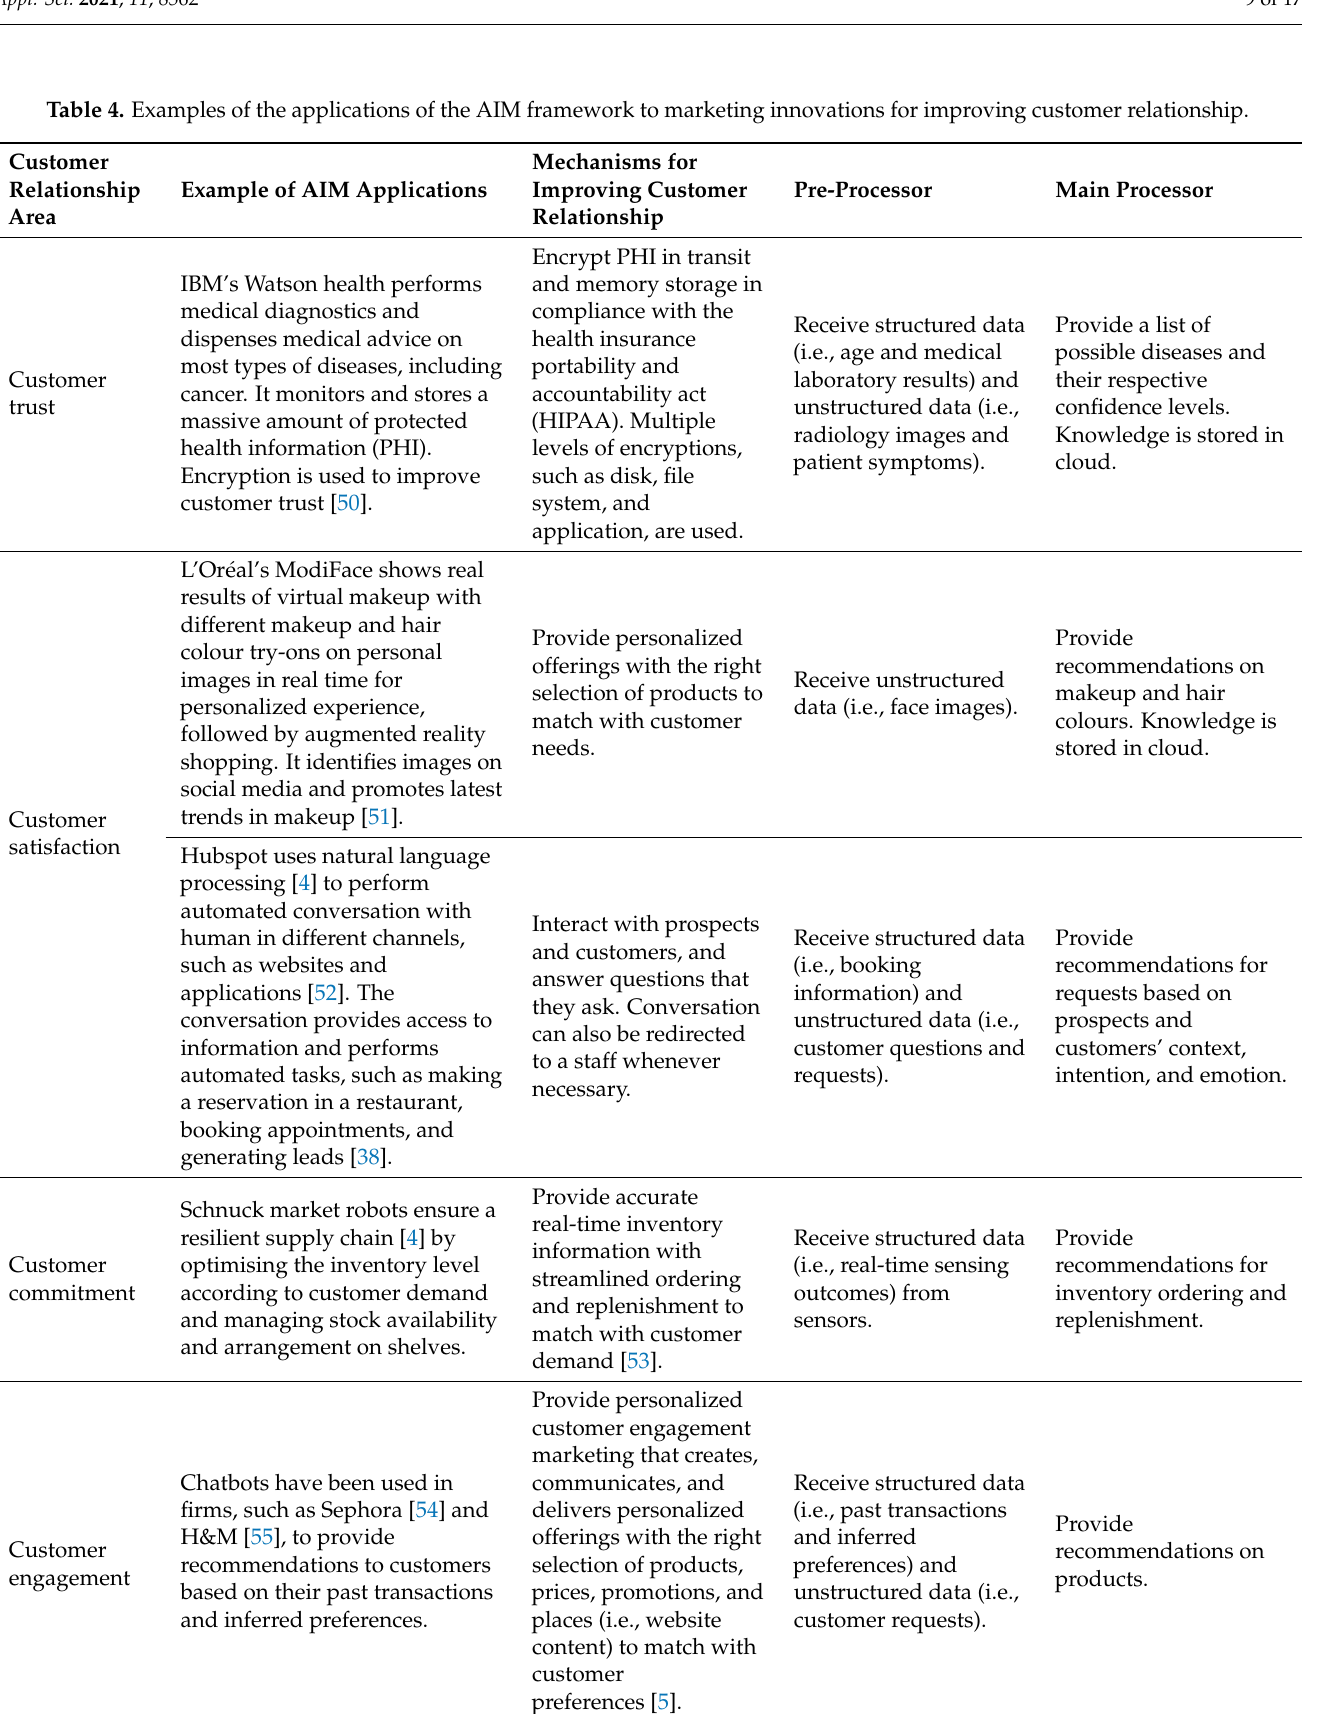
Table 4. Examples of the applications of the AIM framework to marketing innovations for improving customer relationship.